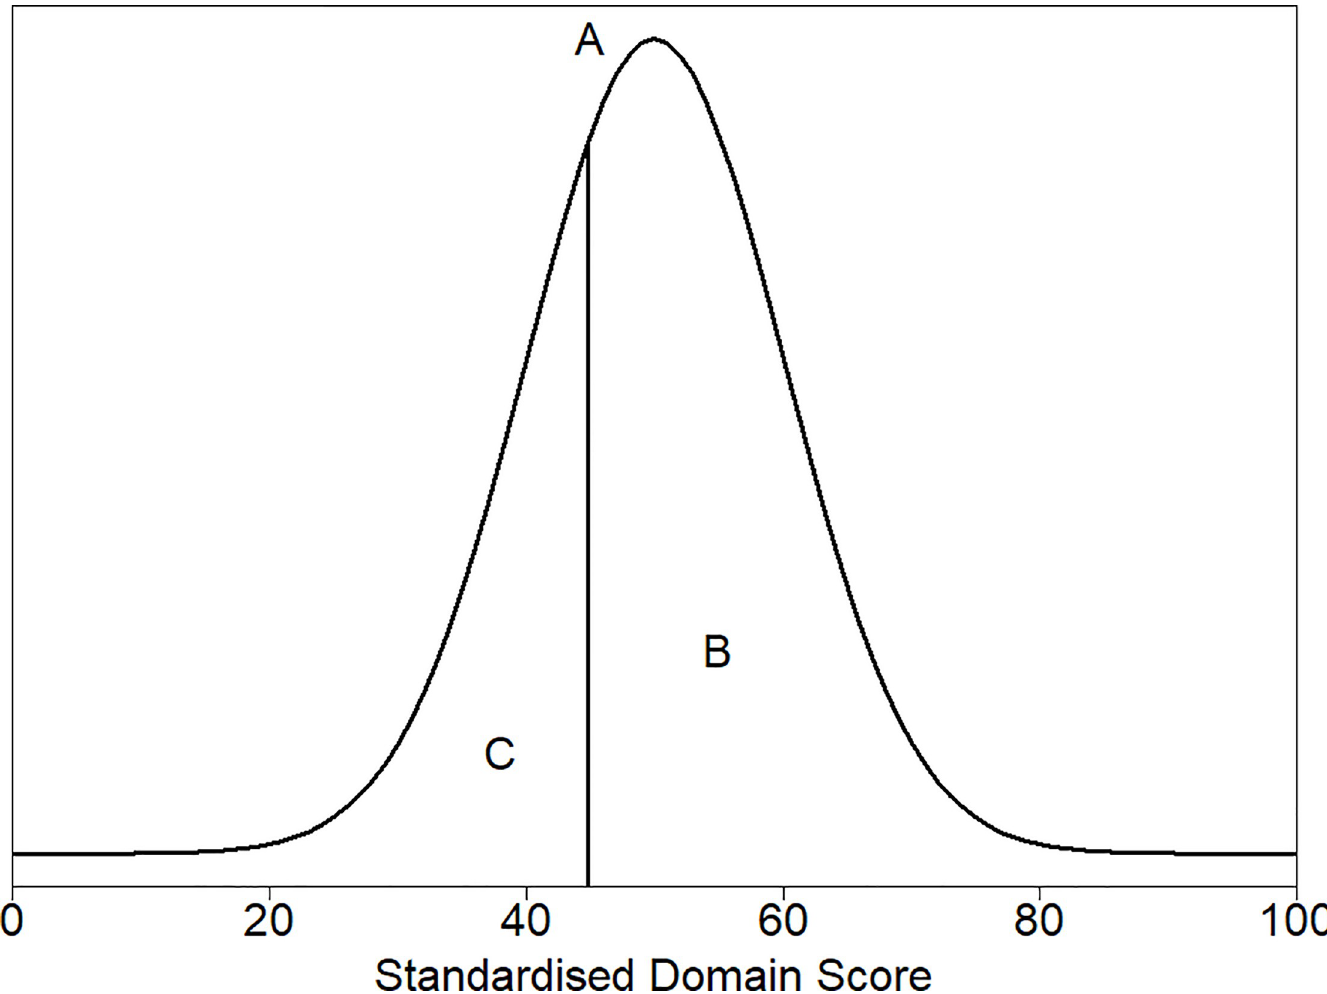
Fig 1. Density plot of the theoretical distribution of the healthy dog populations of both young and old dogs. Marked on the plot is (A) a vertical line denoting the threshold for dividing healthy and sick dogs, the 30 th percentile (a score of 44.8). Above this threshold (to the right on the plot) are 70% of the healthy dog population predicted to be healthy, the area marked by B. Below the threshold (to the left on the plot) are 30% of the healthy dog population predicted to be sick, the area marked by